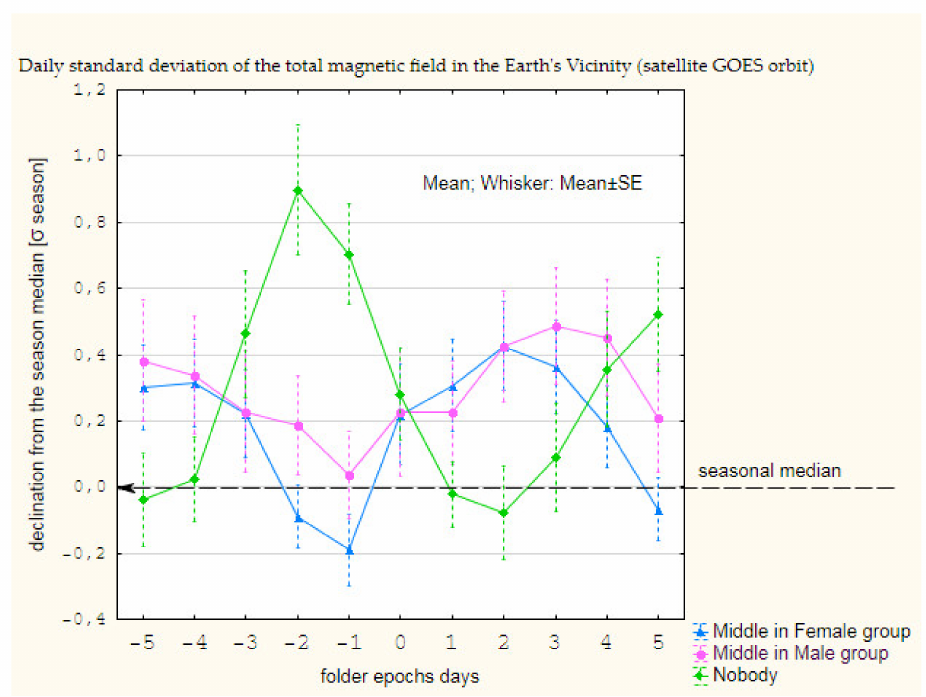
Figure 12. The behavior of the daily standard deviation of the total magnetic field in the Earth’s vicinity near the days of different medical events in the folder epochs interval. The parameter is common for the both gender groups as the assumed factor that can be responsible for different conditions for different medical